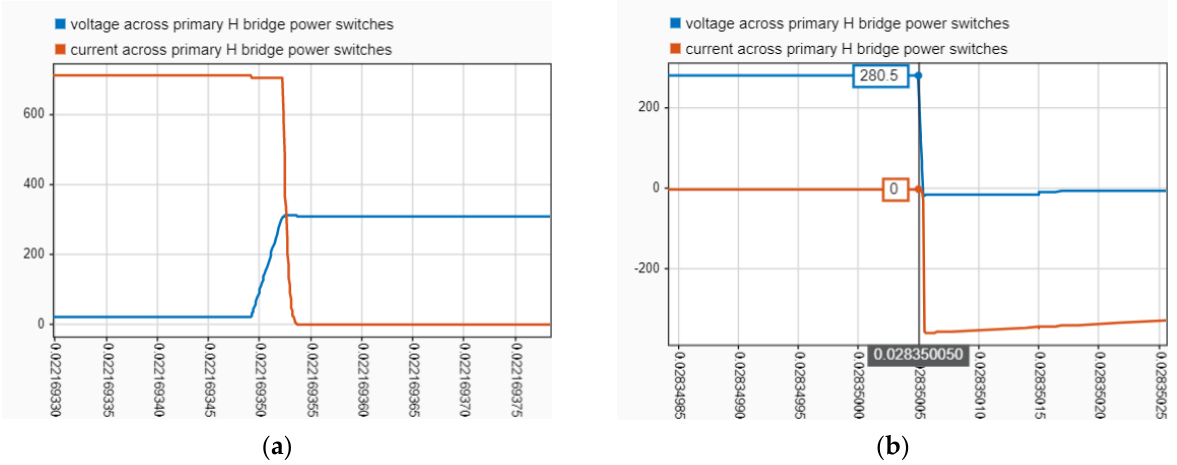
Figure 17. Current and voltage across a power switch of primary H-bridge for 80 kW DAB DC-DC converter under optimal EPS operation, L = 3.15 µH: ( a ) turn-off; ( b ) turn-on.